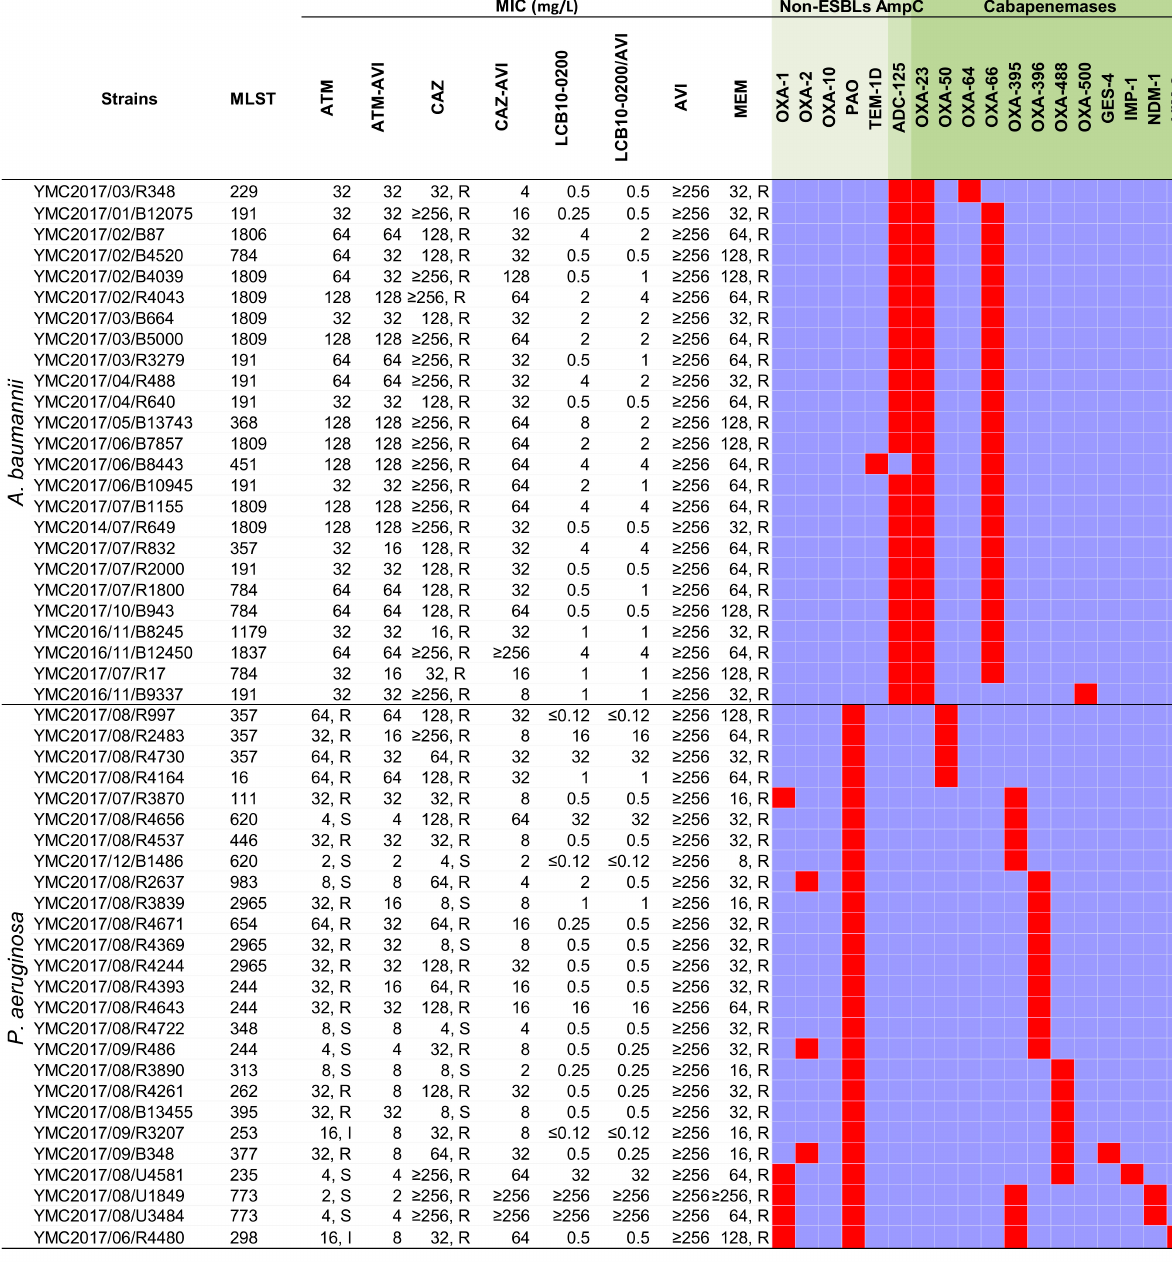
Figure 3. Antibiotic susceptibility and resistome of the carbapenem-resistant A. baumannii and P. aeruginosa strains.Abbreviation: ATM, aztreonam; ATM-AVI: aztreonam/avibactam; CAZ, ceftazidime; CAZ-AVI, cef- tazidime/avibactam; MEM, meropenem; ESBL, Extended-spectrum β -lactamase. Antibiotic susceptibility testing was performed using agar dilution method. Data interpretation was carried out using the CLSI guidelines M100 28th ed. The orchid and red color indicate the absence and presence of antimicrobial resistance genes, respectively. The very light green, light green, green indidate β -lactamses belonging to Non-ESBLs, AmpC, and carbapenemases,